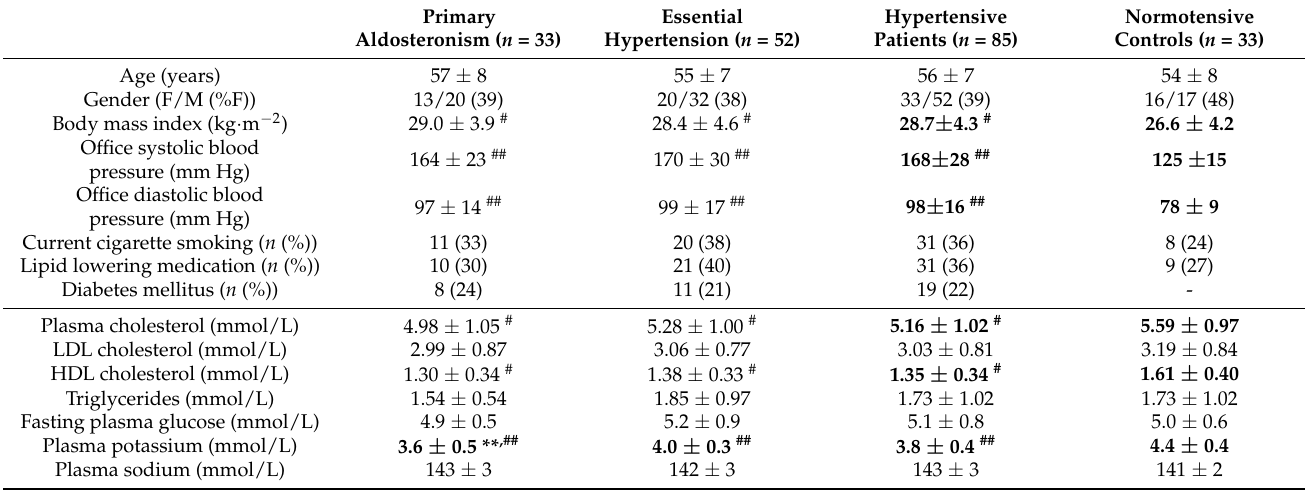
Table 2. Clinical characteristics and humoral data of the study